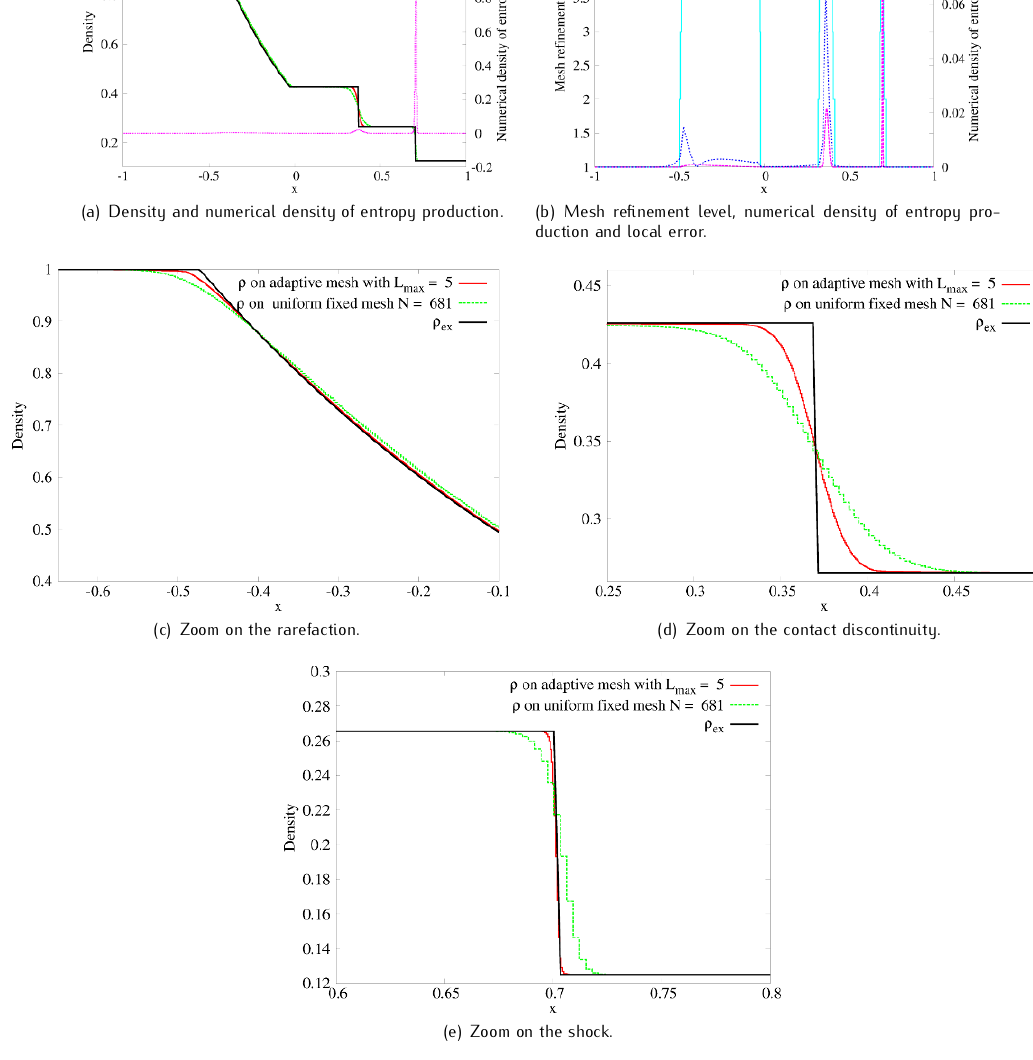
Figure 7. Sod’s shock tube problem: solution at time t = 0 . 4 using the AB1M scheme on the dynamic grid with L the fixed uniform grid of 681